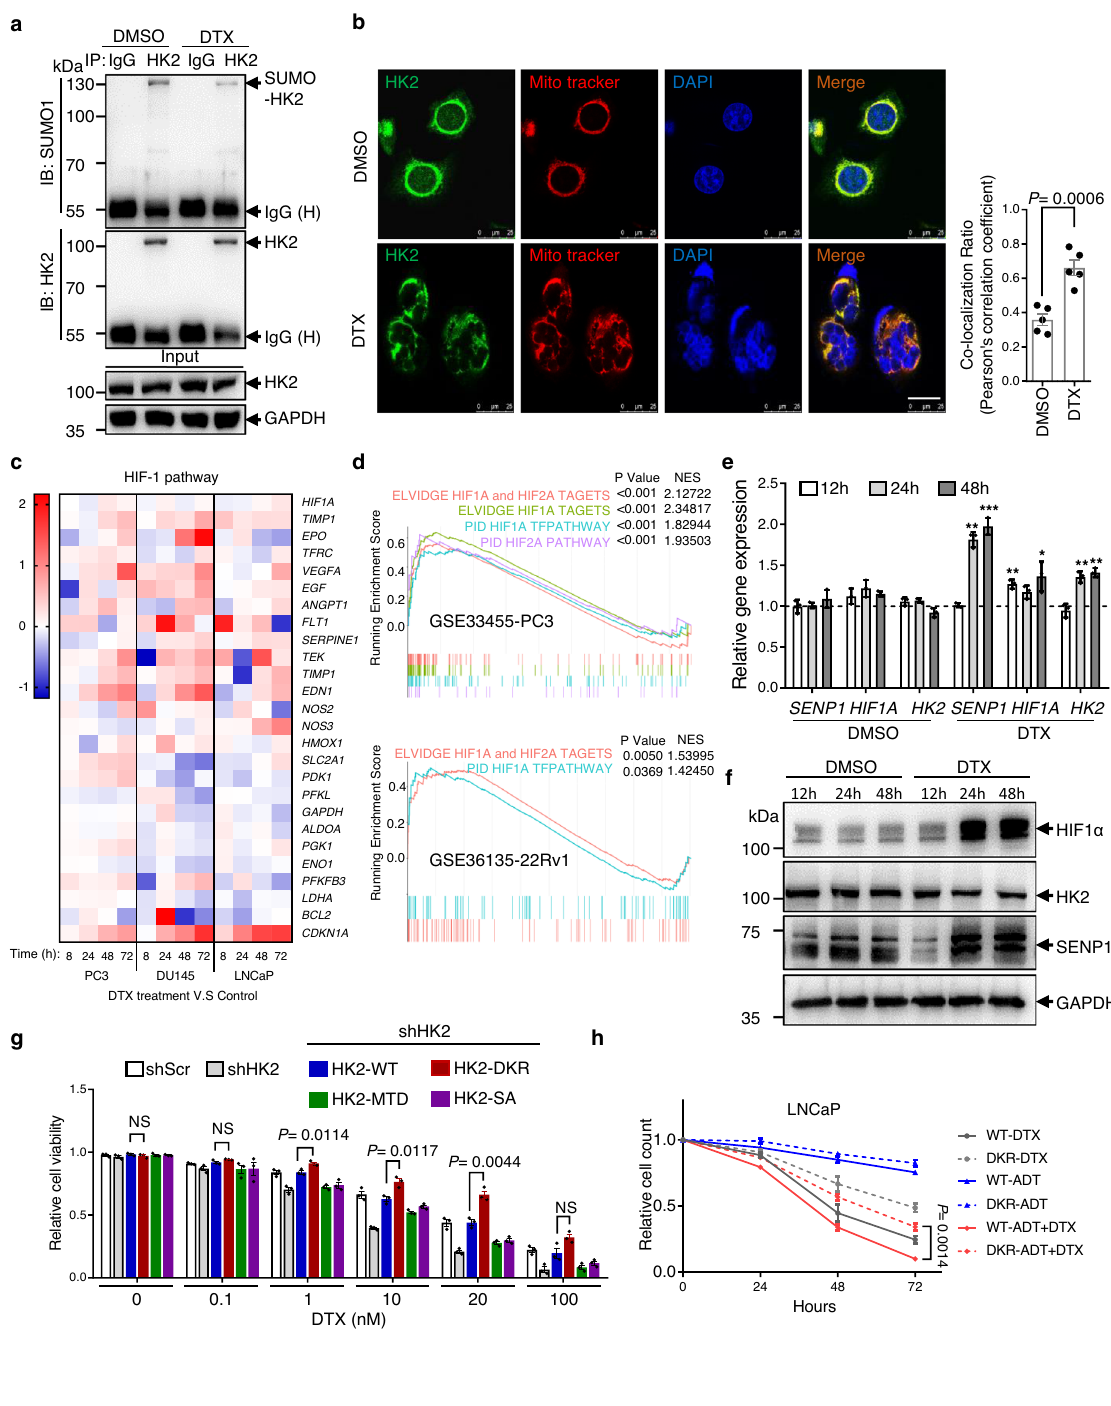
process 27 – 29 . HK2 levels are high in prostate cancer, especially in association with poor prognosis. In the Pten PC − / − / Tp53 PC − / − prostate cancer mouse model, HK2 is required for tumorigenesis. Prostate-speci fi c PTEN deletion activates the